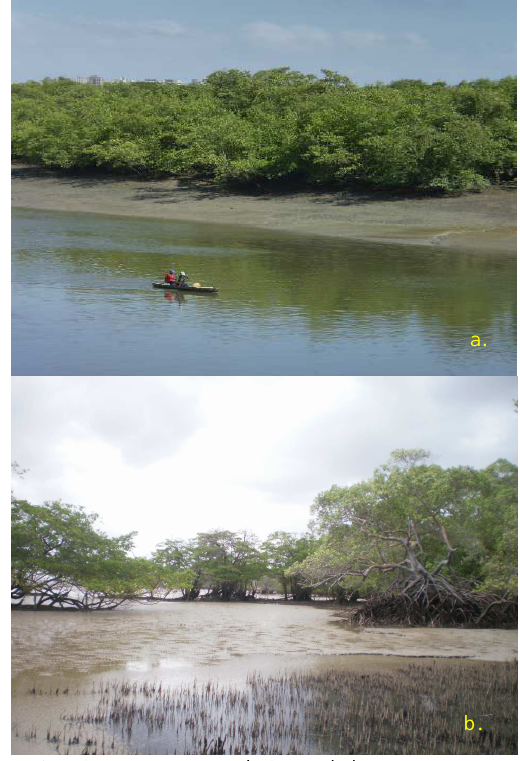
Figure 3: a. Dense mangrove; b. Degraded mangrove.